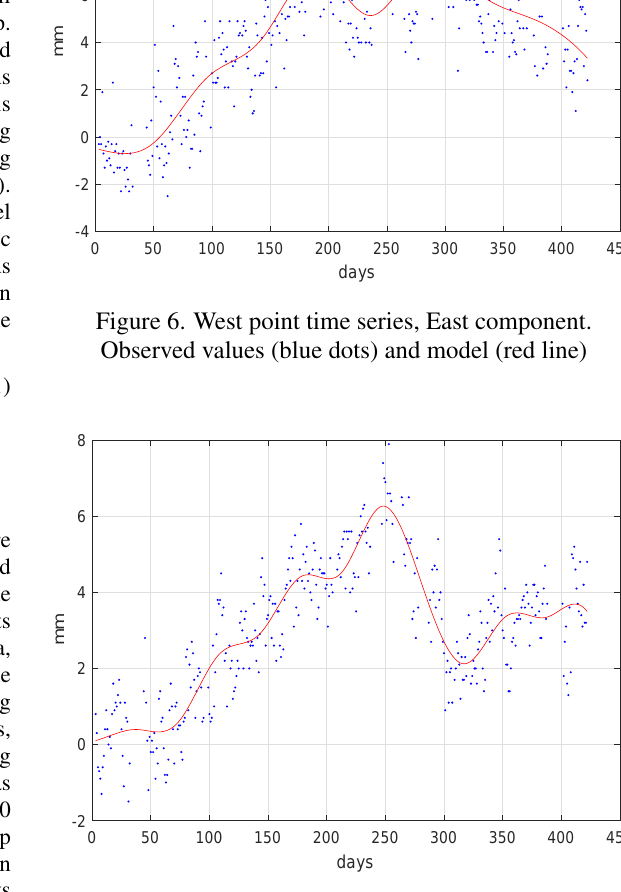
Figure 7. West point time series, North component. Observed values (blue dots) and model (red line)